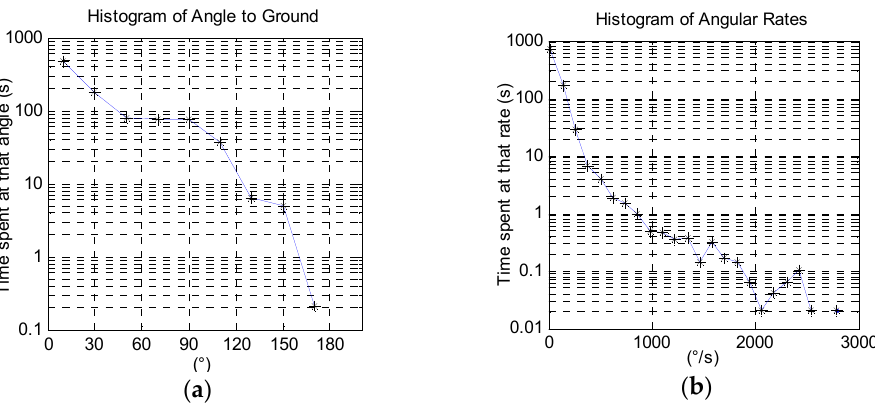
Figure 4. ( a ) Histogram of the angle between the device x -axis and nadir; ( b ) histogram of angular rate magnitude. The data are from a 15.5 min recording of a subject performing the exercises in Table 1.